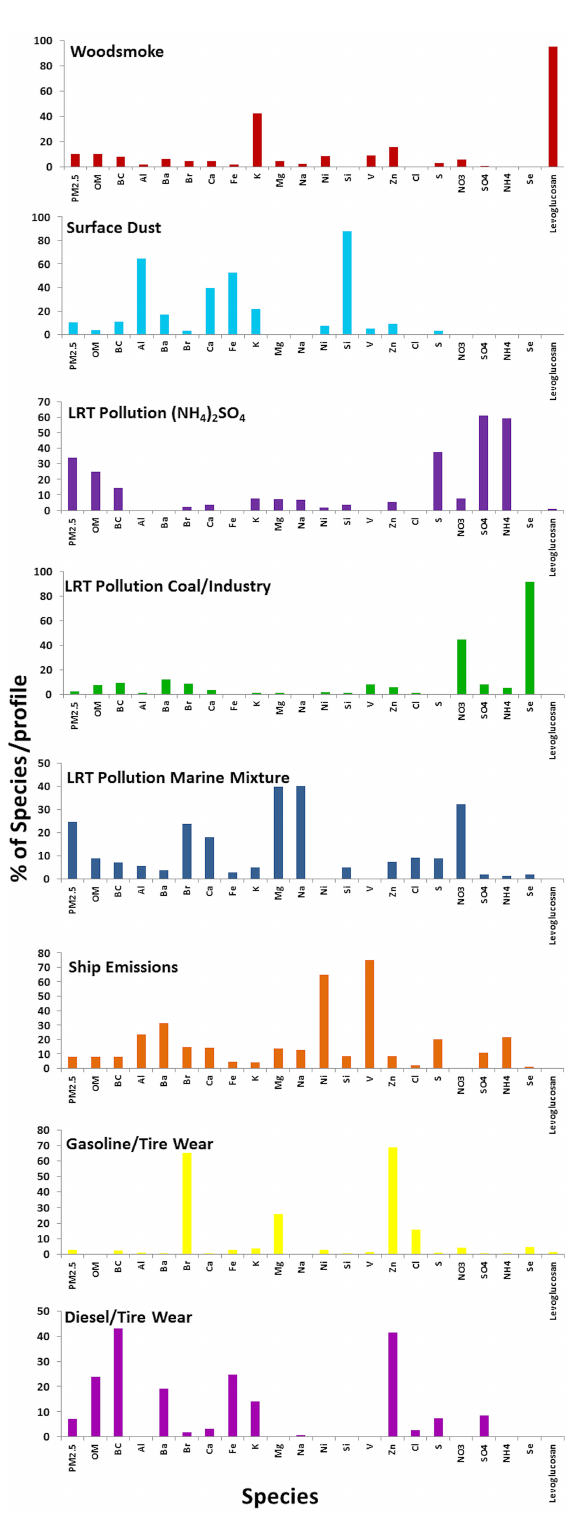
Figure 2. Positive matrix factorization chemical species source fac- tor profiles and associated percentage mass